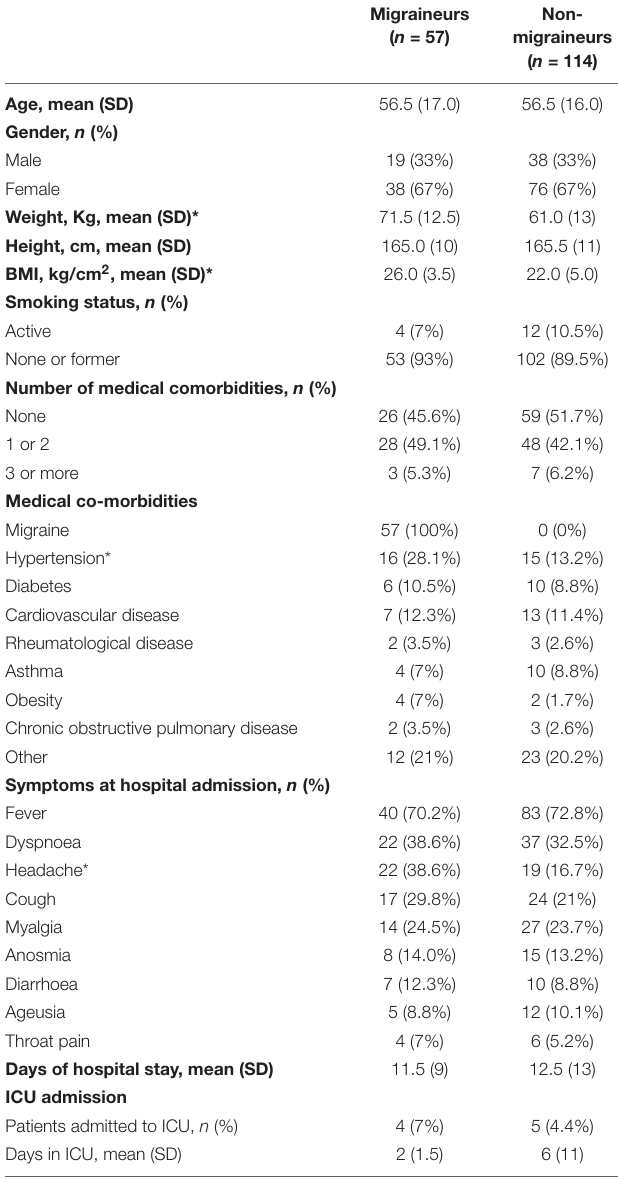
TABLE 1 | Demographic and hospitalisation data of coronavirus disease 2019 (COVID-19) patients with and without pre-existing migraine history.